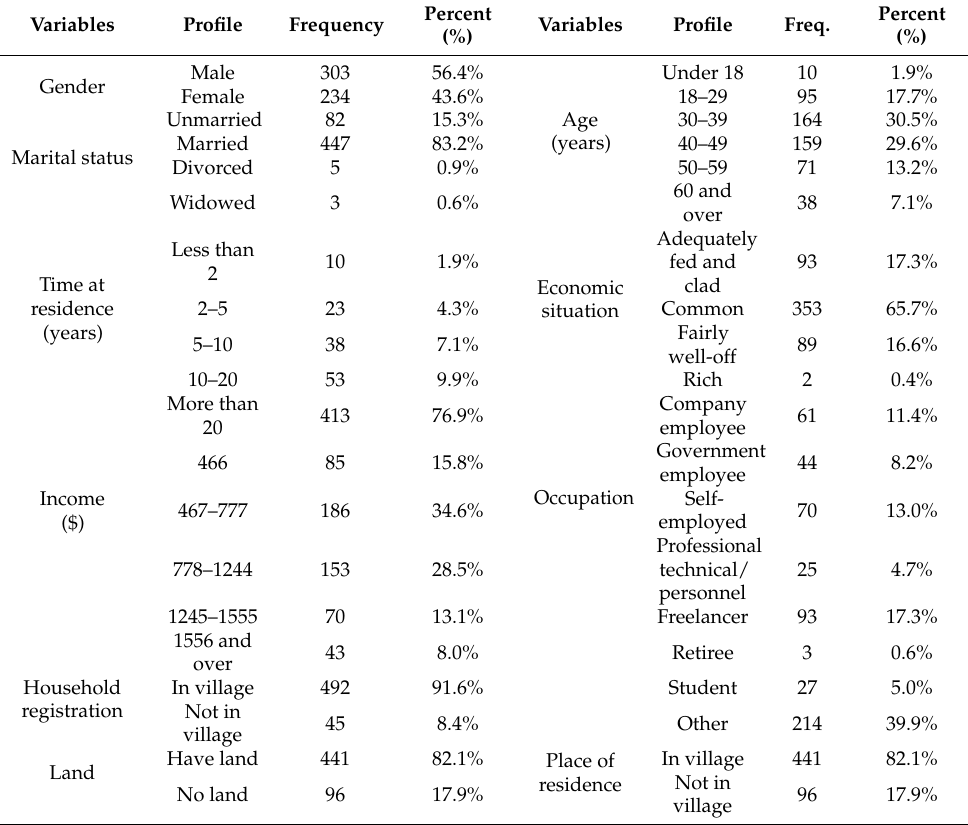
Table 3. Survey sample profile (n =